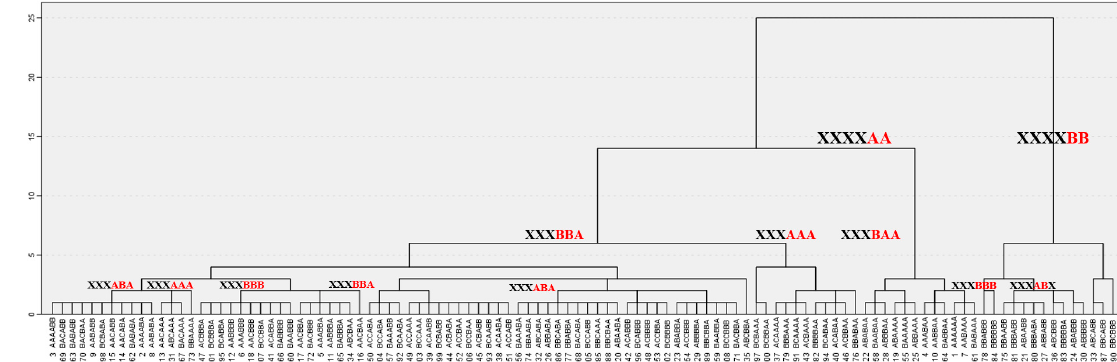
Figure 5. Diagram of hierarchical cluster analysis.